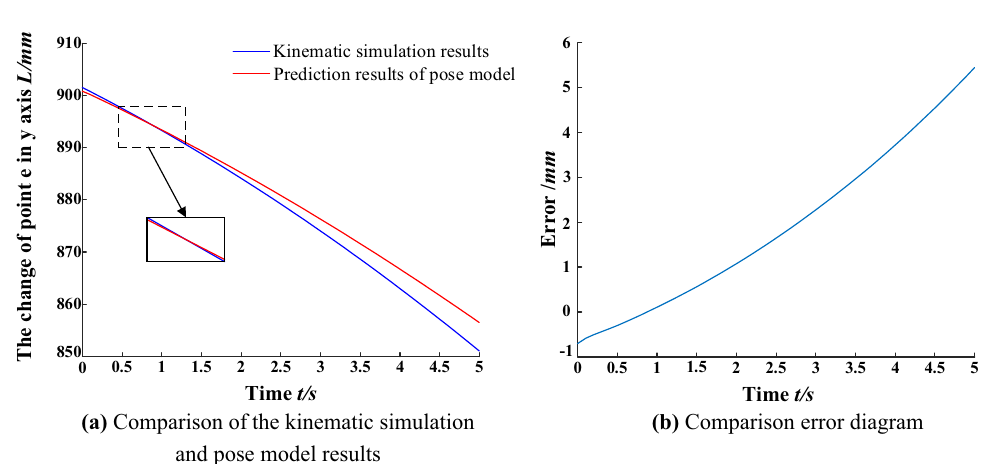
Figure 14. Comparison of the kinematic simulation results of the monitoring point y-axis variation.